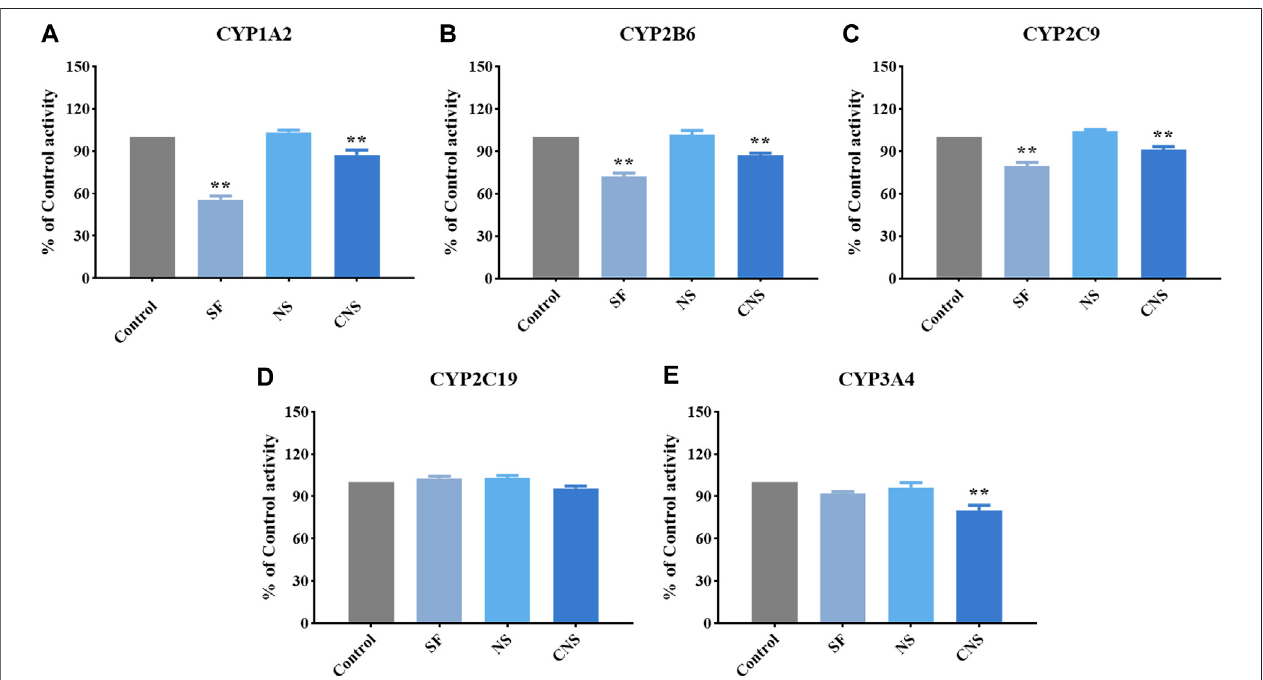
FIGURE 4 | Effects of CNS, NS, and SF on the activity of CYP1A2 (A) , CYP2B6 (B) , CYP2C9 (C) , CYP2C19 (D) , and CYP3A4 (E) (mean ± SD, n (cid:2) 3, ** p < 0.01).